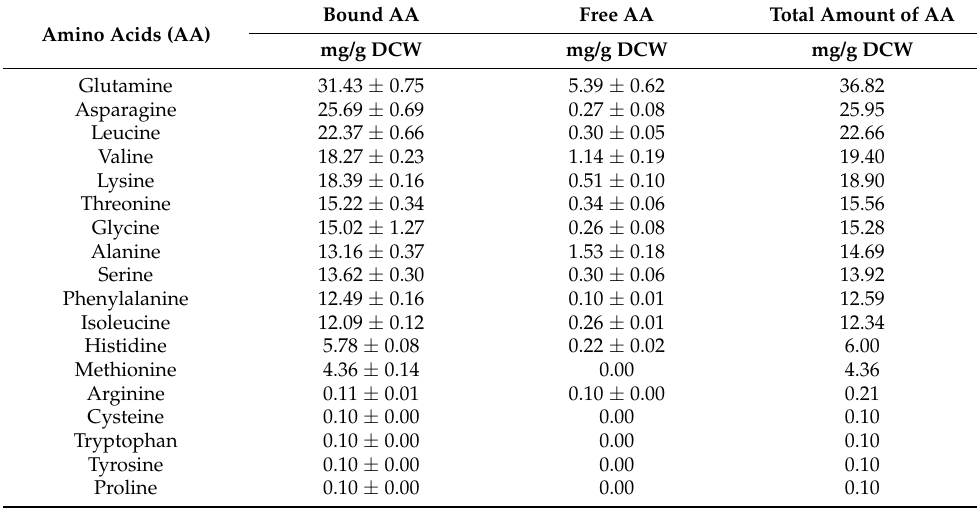
Table 5. Amino acid composition of Y. lipolytica VKM Y-2373 at 6 g/L (NH 4 ) 2 SO 4